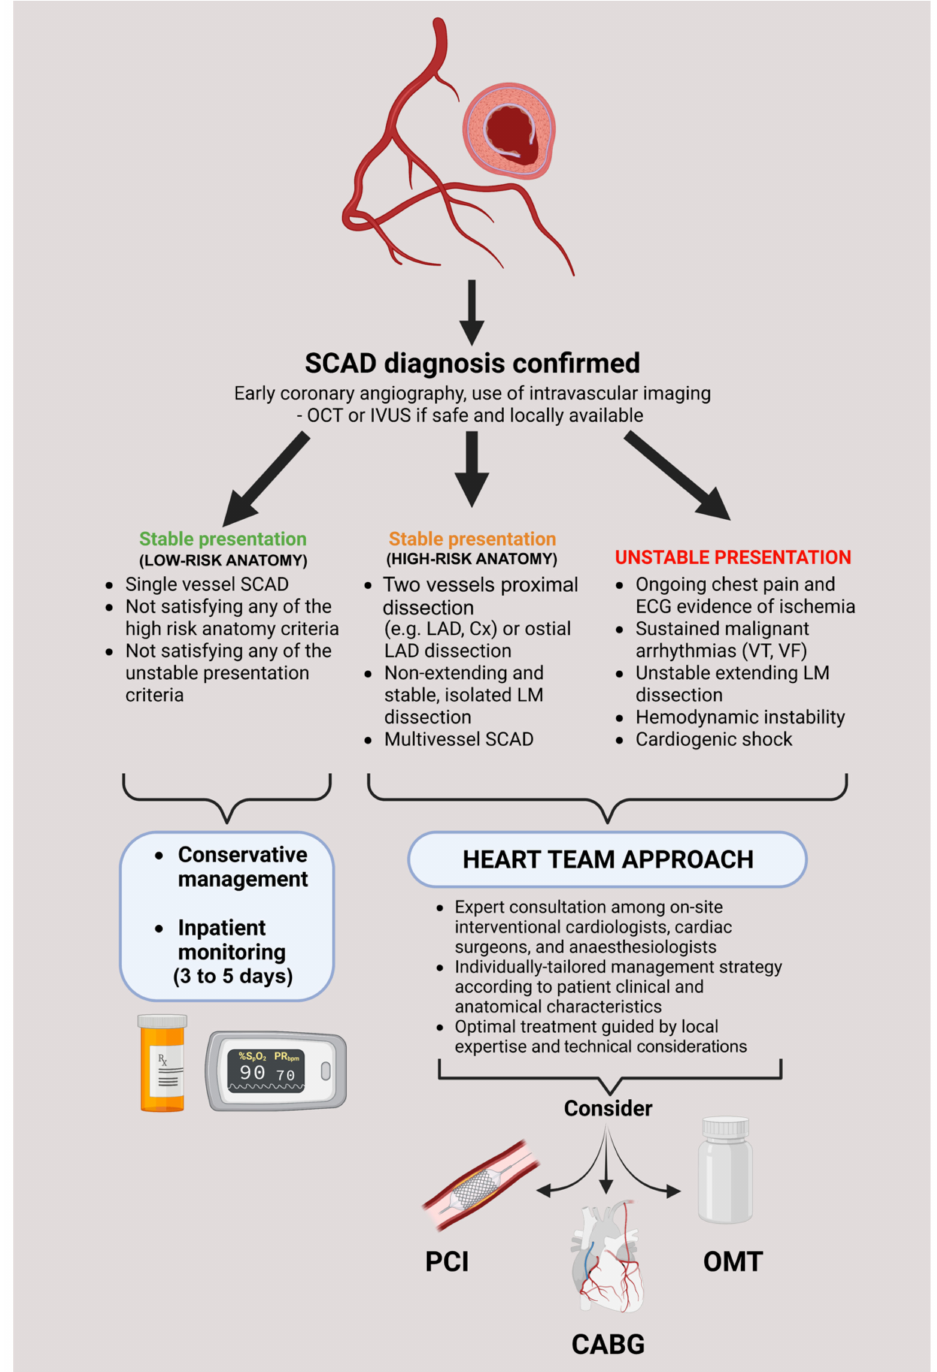
Figure 3. A decision tree in approaching confirmed SCAD cases during coronary